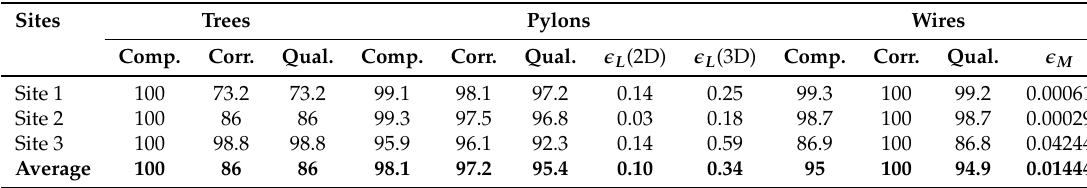
Table 5. Point-based evaluation on the three sites against the ground truth presented in Table 3 (completeness, correctness and quality are in percentage; localisation error (cid:101) L for pylons and modelling error (cid:101) M for wires are in